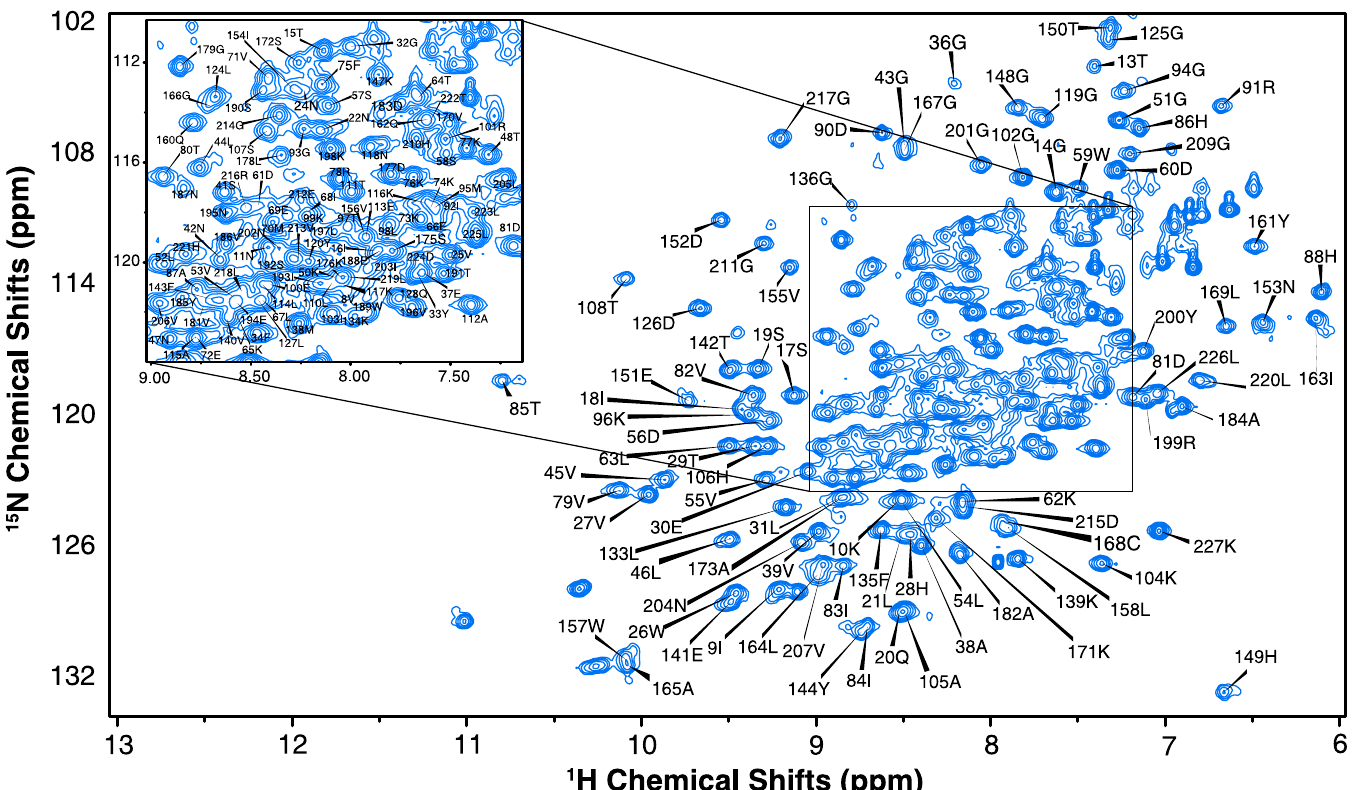
Fig 3. 2D 1 H- 15 N HSQC spectra of 5/B/6 MBL. Amino acid assignments are indicated. Inset is a magnification of the more crowded region.